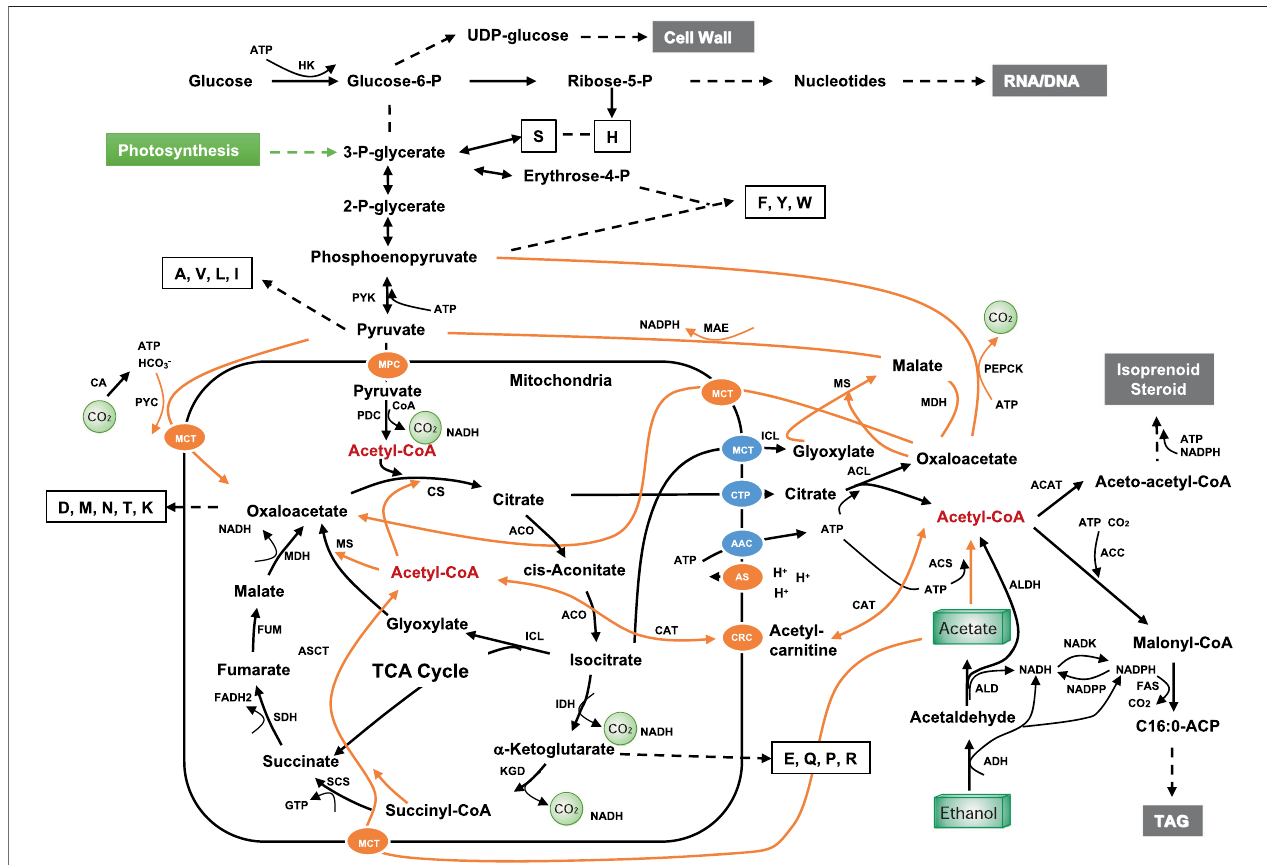
FIGURE9| MetabolicpathwayforC2feedstock.Dottedlinesindicatemultiplesteps;lettersinemptyboxesindicatethesinglelettercodesforaminoacids;orange lines indicate potential routes for C2 feedstock utilization; AAC, ADP/ATP carrier protein; ACC, acetyl-CoA carboxylase; ACAT, acetyl-CoA acetyltransferase; ADH, alcoholdehydrogenase;ALD, aldehyde dehydrogenase; ALDH, Acetaldehyde dehydrogenase (EC 1.2.1.10); ACO, aconitase; ACS,acetyl-CoA synthetase; ACL, ATP- citratelyase;AS,ATPsynthase;ASCT,acetate:succinate CoA-transferase;CA,carbonicanhydrase; CAT,carnitineacetyltransferase; CRC,carnitinecarrier; CTP, mitochondria citrate transporter; CS, citrate synthase, FAS, fatty acid synthase; FUM, fumarase; HK, hexokinase; IDH, isocitrate dehydrogenase; ICL, isocitrate lyase; KDG, α -ketoglutarate dehydrogenase complex; MAE, malic enzyme; MDH, malate dehydrogenase; MPC, mitochondrial pyruvate carrier; MS, malate synthase; NADK, NAD+ kinase; NADPP, NADPH phosphatase; SCS, succinyl-CoA synthetase; SDH, succinate dehydrogenase; PDC, pyruvate dehydrogenase complex; PEPCK, Phosphoenolpyruvate carboxykinase; PYC, pyruvate carboxylase; PYK, pyruvate kinase; MPC, mitochondrial pyruvate carrier; MCT, monocarboxylate transporters. The feeding point to photosynthetic product in plants and algae is shown in